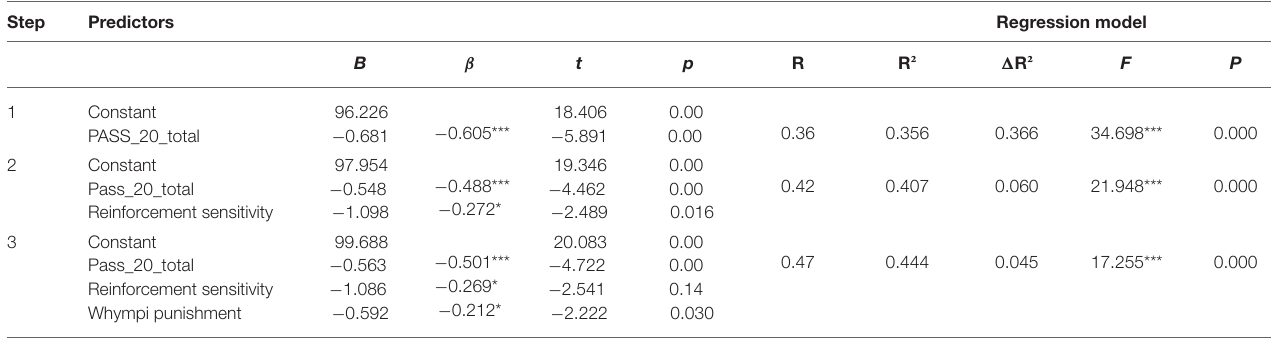
TABLE 2 | Multiple stepwise linear regression analysis of pain-related anxiety, sensitivity to punishment and reinforcement, and the punishing responses of significant persons toward pain behaviors, on the acceptance of pain*. Step